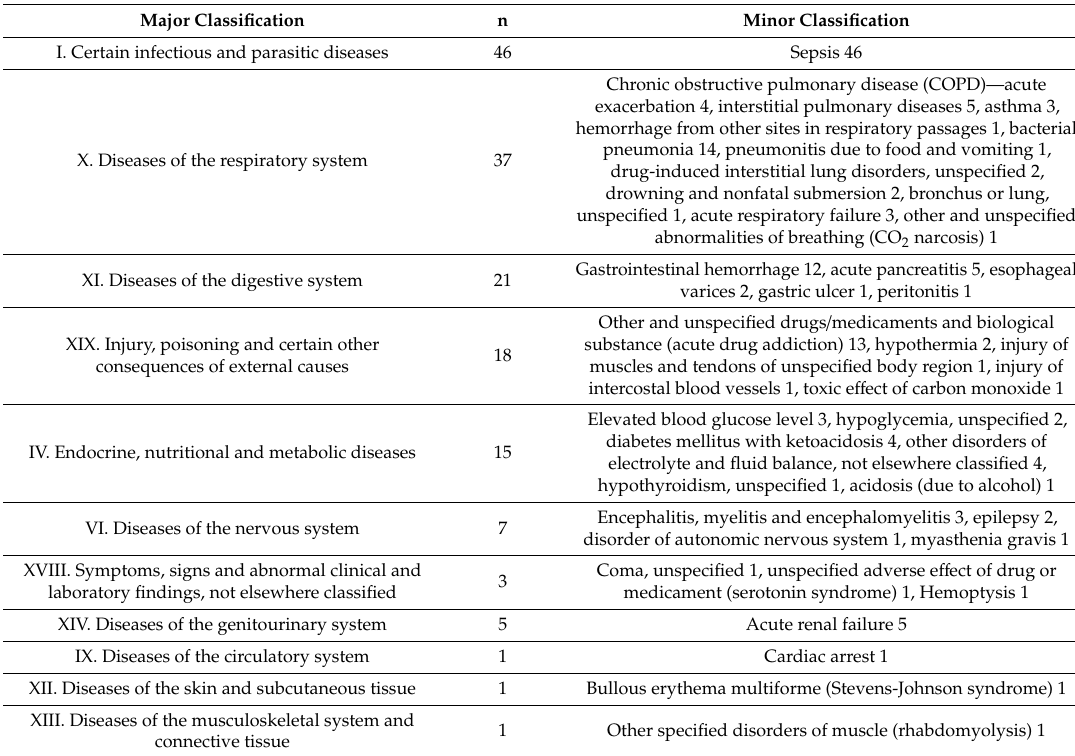
Table 1. Patient characteristics (classified according to the ICD-10*).